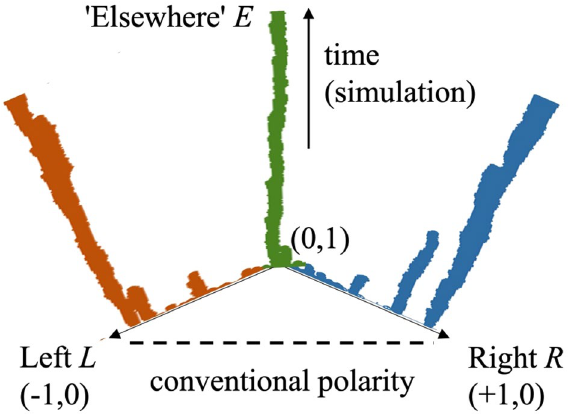
Figure 6. Computer simulation of the Seceder mechanism of Dittrich et al. and Halpin-Healy et al. 48–50 . Though a similar finding of emergent branches appears for more general dimension choices, for illustrative purposes we generated this output by splitting the simple one-dimensional output into values from 0 to 0.5 to provide one axis (branches and clustering shown in orange) and 0.5 to 1 to provide another (branches and clustering shown in blue) hence the triangular shape for the x axis. The green branch mimics the Boogaloo movement and classifies as ‘elsewhere’ since it is neither on the left or right of the one-dimensional axis. Each colored dot represents the position of an agent in the system at a particular time and with a particular value along the one- dimensional line. The branches emerge as a result of the model’s competition between the pressure to conform and the desire to dissent. The plot shows the aggregation of agents around specific values, so the wider the line, the more agents with similar values in that branch. Since the vertical axis is time in the computer simulation, each branch generates a tall structure with height equal to the time. Since the sizes of these branches of individuals fluctuate as time progresses, these tall structures have non-constant